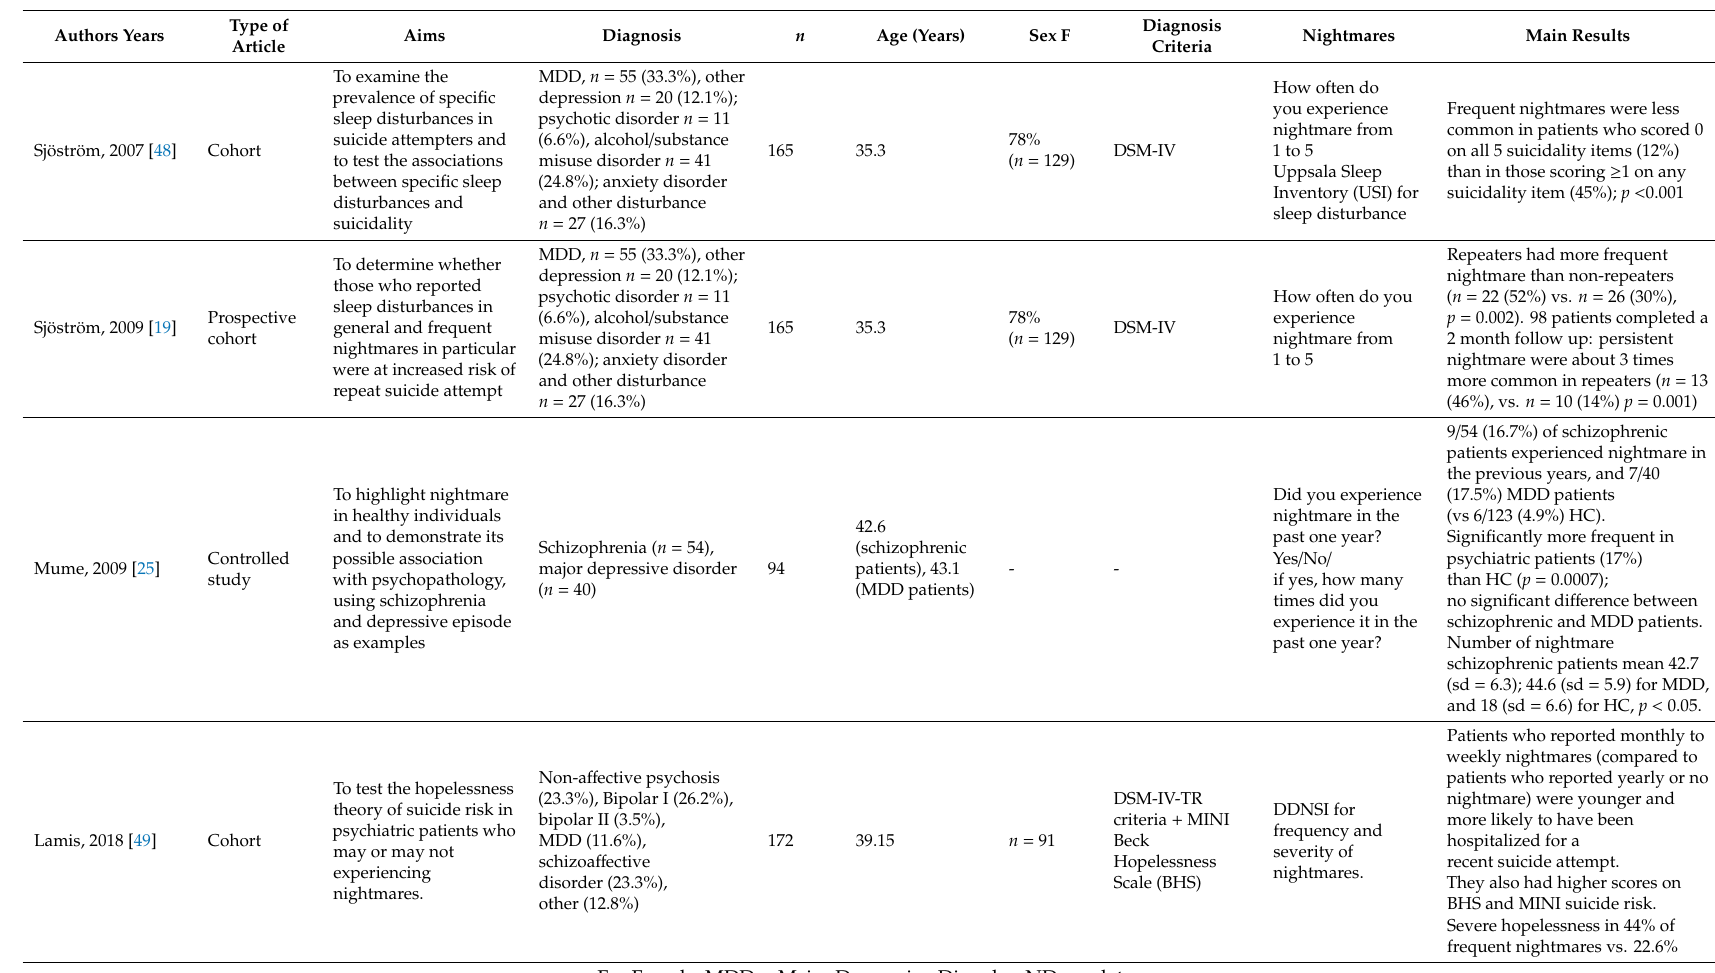
Table 3. Studies comparing psychiatric disorders and